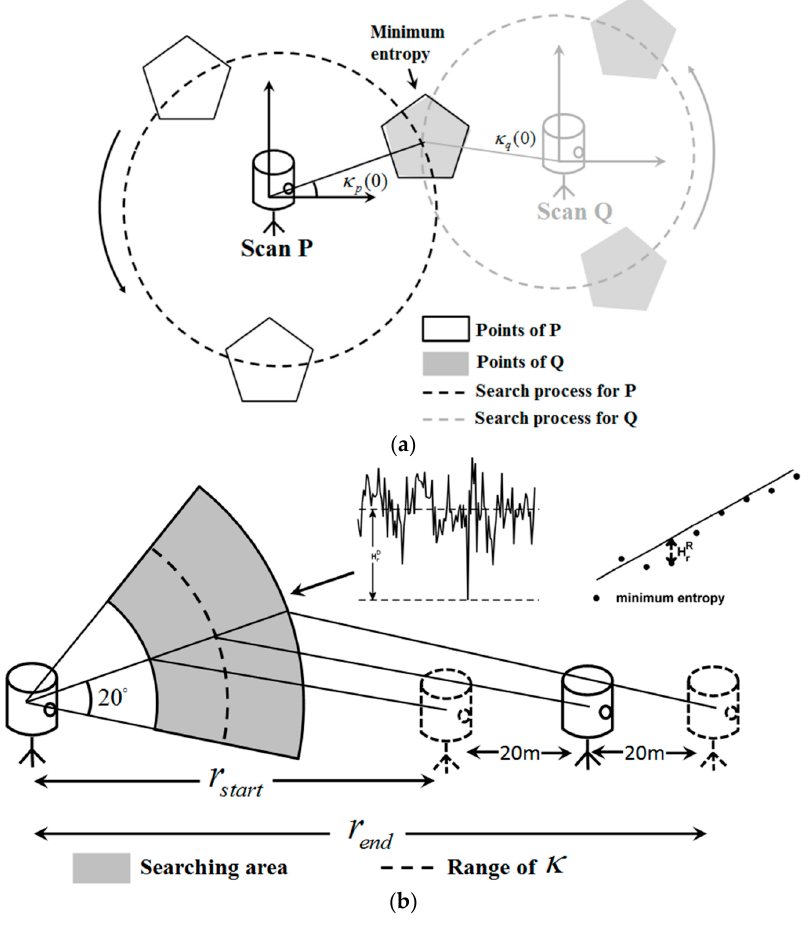
Figure 5. Search for the initial parameters: ( a ) the searching process for rotation angles; and ( b ) the searching process for initial scan distance.